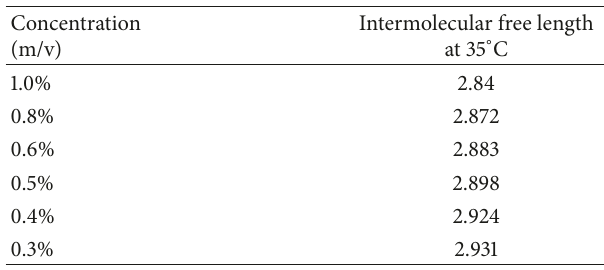
Table 6: Intermolecular free length ( × 10 −13 m) at different concen- tration at 1MHz for polyvinyl alcohol (PVA).